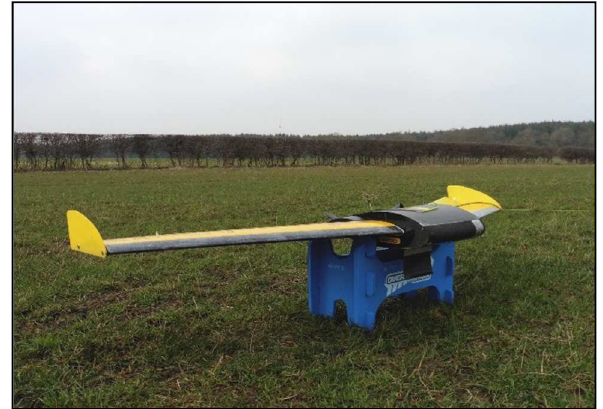
Figure 1. QuestUAV Qpod fixed-wing UAV.